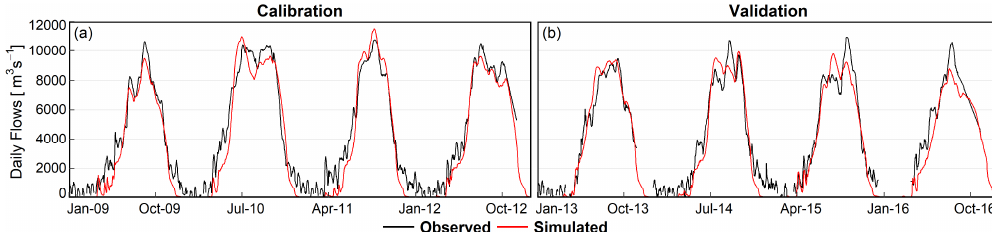
Figure 14. Daily observed streamflows (black) and simulated streamflows (red) produced by the improved rainfall dataset (the IMLC product) for the periods of ( a ) calibration (2009–2012) and ( b ) validation (2013–2016) using the RRI model at the Bhairab Bazar stream gauge. See Table 4 for the statistical metrics used to evaluate the simulated streamflows.